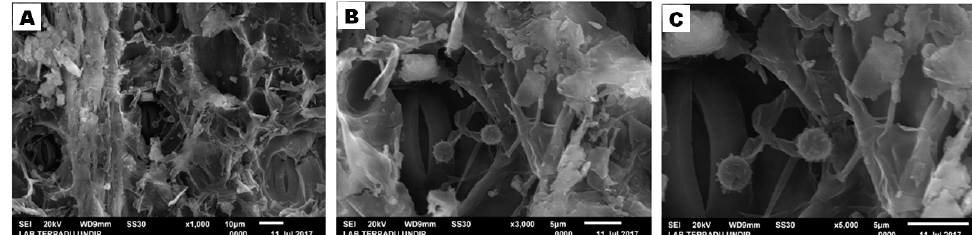
Figure 9. Result of SEM EDX of hemp fiber with magnification of: ( A ). 1000x; ( B ). 3000x, and ( C ) 5000x.